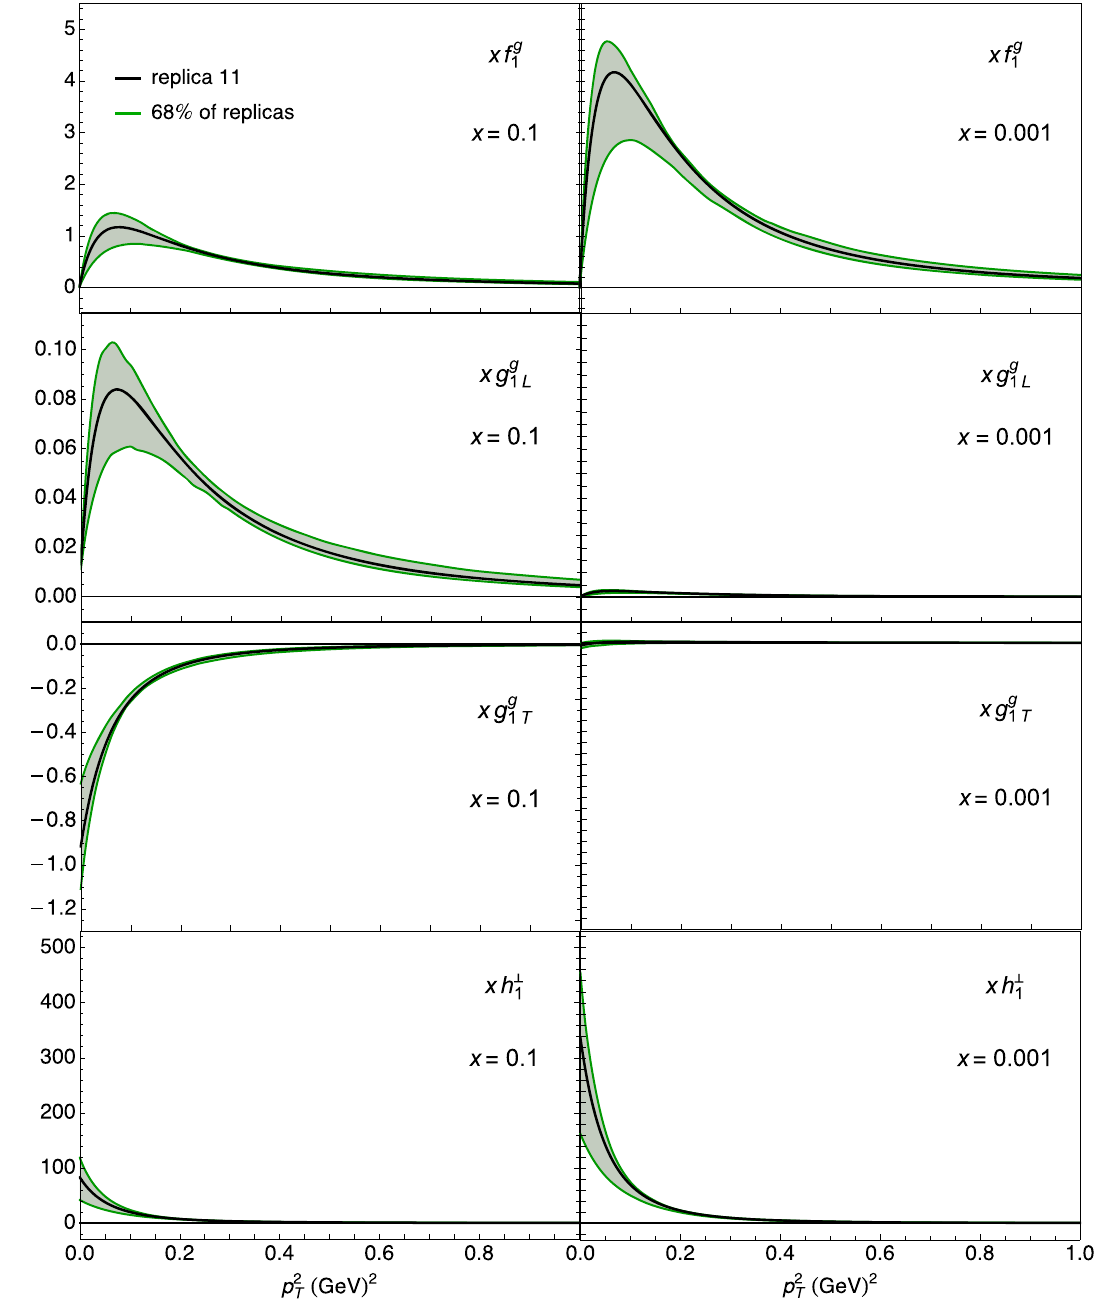
Fig. 4 The T -even gluon TMDs as functions of p 2 the 68% statistical uncertainty, solid black line for the replica 11. From top to bottom, panels show x f g ⊥ g ( x , p 2 ) xh T 1